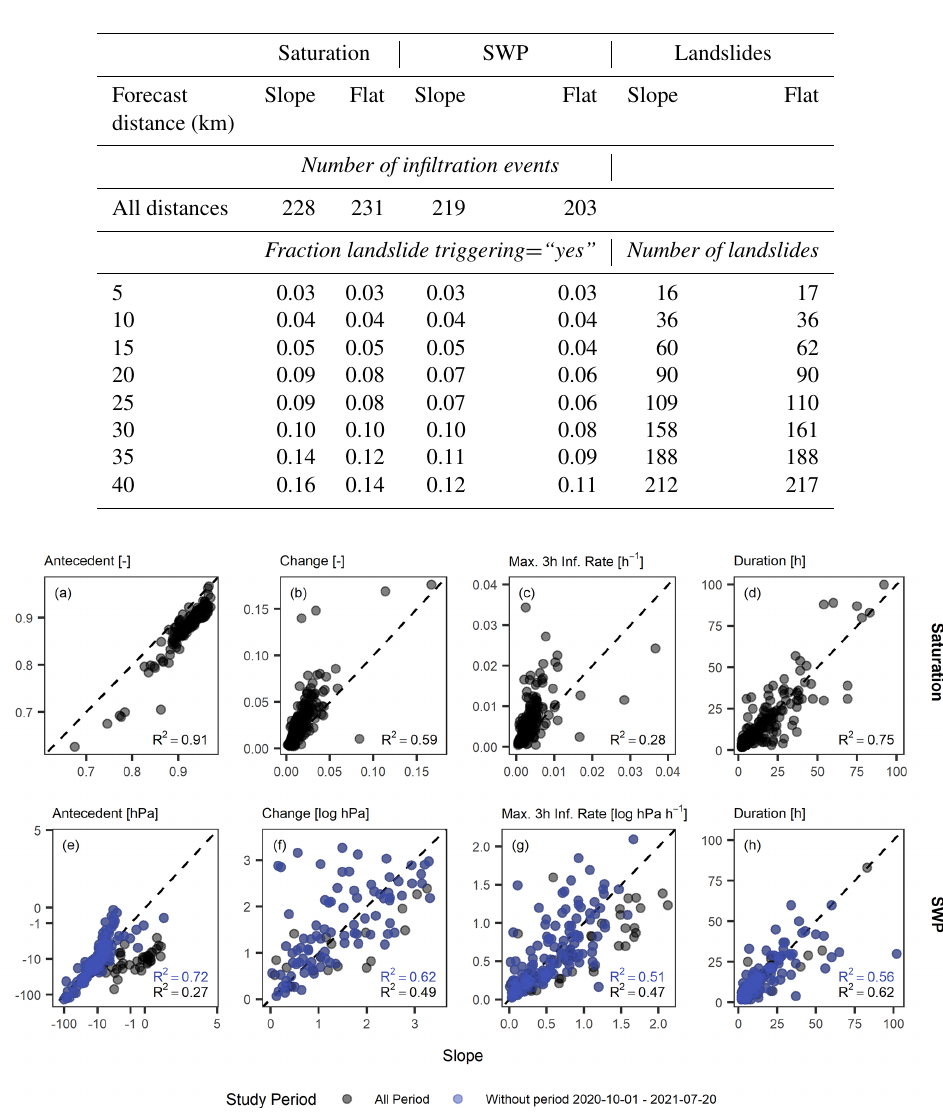
Figure 7. The infiltration event properties antecedent wetness, wetness increase, maximum 3h infiltration rate and event duration for satu- ration (a–d) and SWP (e–h) showing the slope vs. flat site. The blue points and R 2 values in (e–h) disregard the period 1 October 2020– 20 July